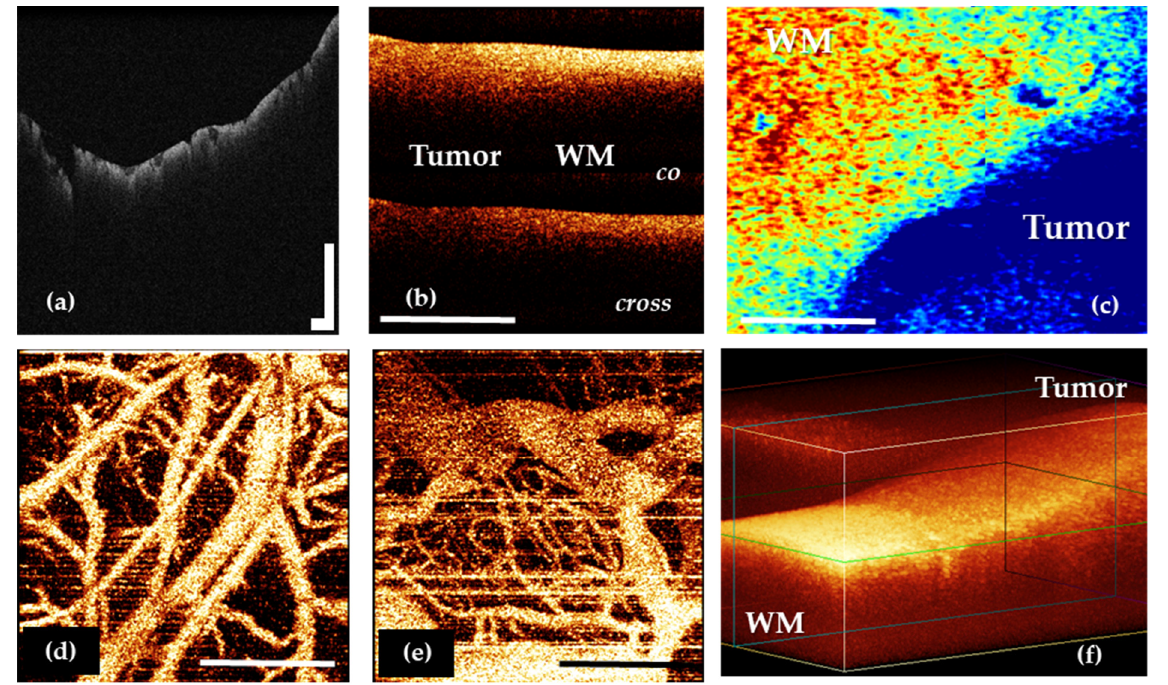
Figure 2. OCT data types in neuro-oncology: 2D OCT images of brain tissue obtained by OCT-integrated microscope ( a ) and portable CP OCT system with handled probe ( b ); based on attenuation coefficient color-coded map of border between white matter and glioma obtained by CP OCT device from human biopsy sample ( c ); OCTA images of cortex ( d ) and glioblastoma 101.6 in rat ( e ); 3D OCT image of border between white matter and glioma ( f ). WM—white matter. Scale bar is 1 mm in all images.